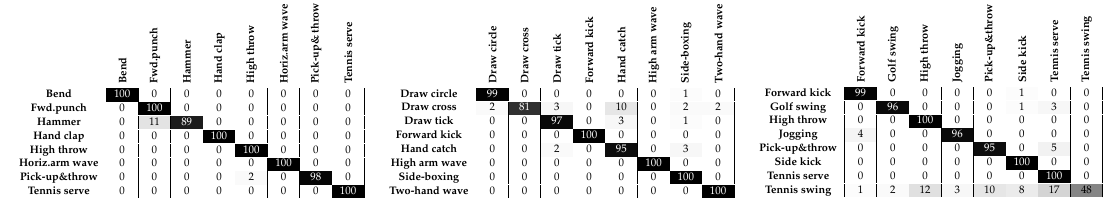
Figure 9. Confusion matrix of spatial information and central-oriented fuzzy weighted multi-resolution DMMs (FWMDMMs) based method, using CS validation scheme in terms of AS1 ( left ), AS2 ( middle ) and AS3 ( right ) subsets of MSR 3D action dataset.